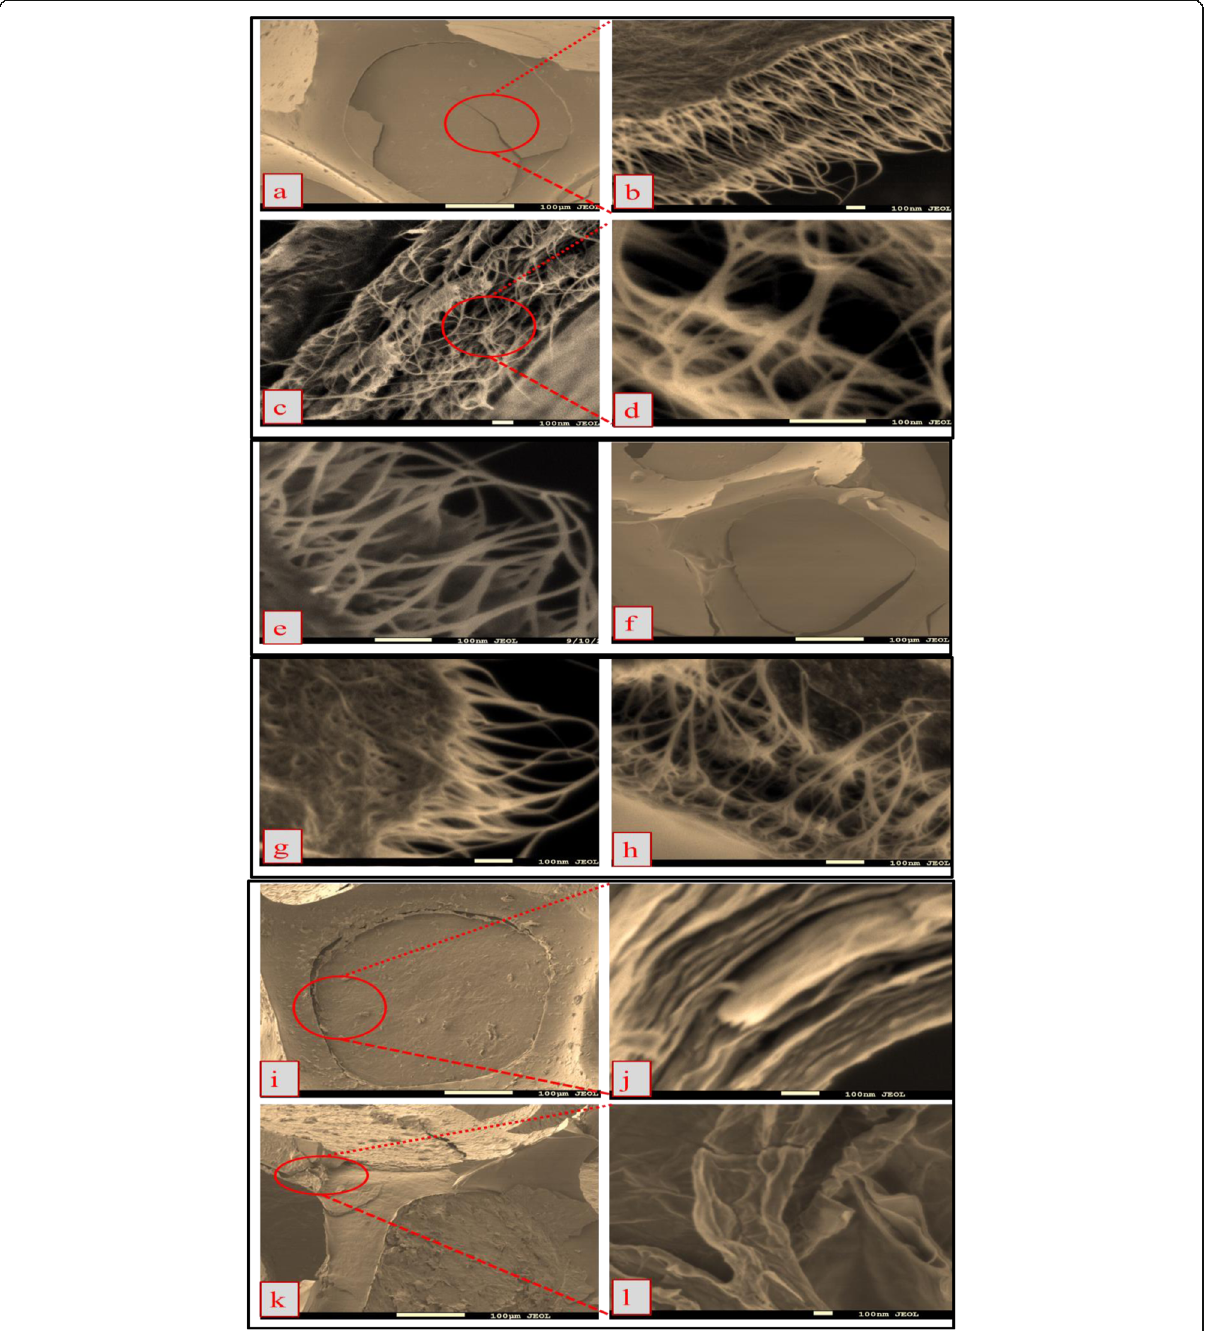
Fig. 1 SEM images of the a top surface, b 45° view, and c – e cross-section of 9-CNT/mwGO/RVC electrode; f top surface, g 35° view, and h cross- section of 8-CNT/mwGO/RVC electrode; i top surface and j 45° view of 7-CNT/mwGO/RVC electrode; and k top surface and l 45° view of mwGO